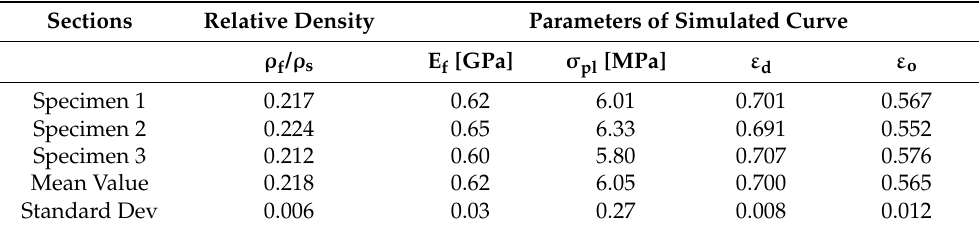
Table 5. Relative density and parameters of simulated compression curve: comparison between longitudinal sections of Specimen 1 (XZ), Specimen 2, and Specimen